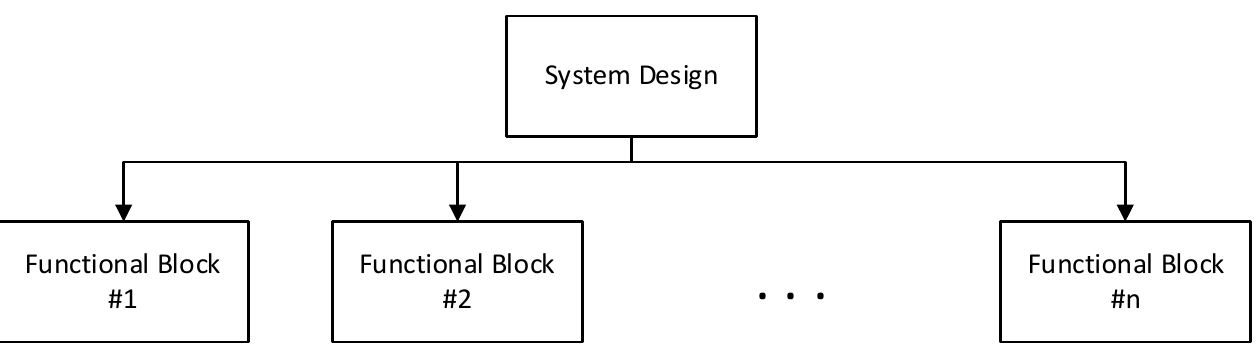
Figure 6. Breakdown structure of a functional block design.